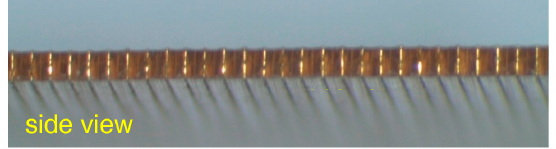
Figure 2. Photograph of an ACP with ZebraStripes TM technology